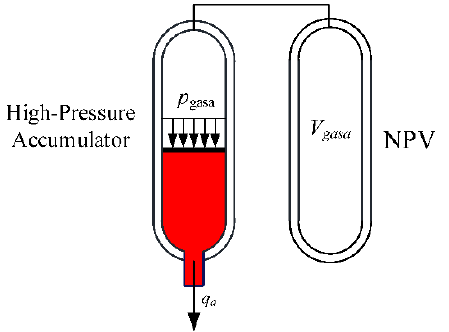
Figure 3. Model of accumulator and NPV.